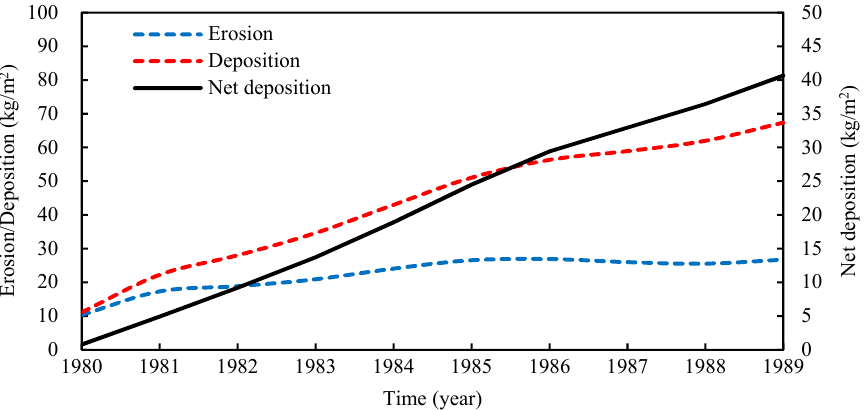
Figure 13. Amounts of erosion (blue dashed line), deposition (red dashed line) and net deposition (solid black line) per unit area for the QL system from 1980 to 1989.